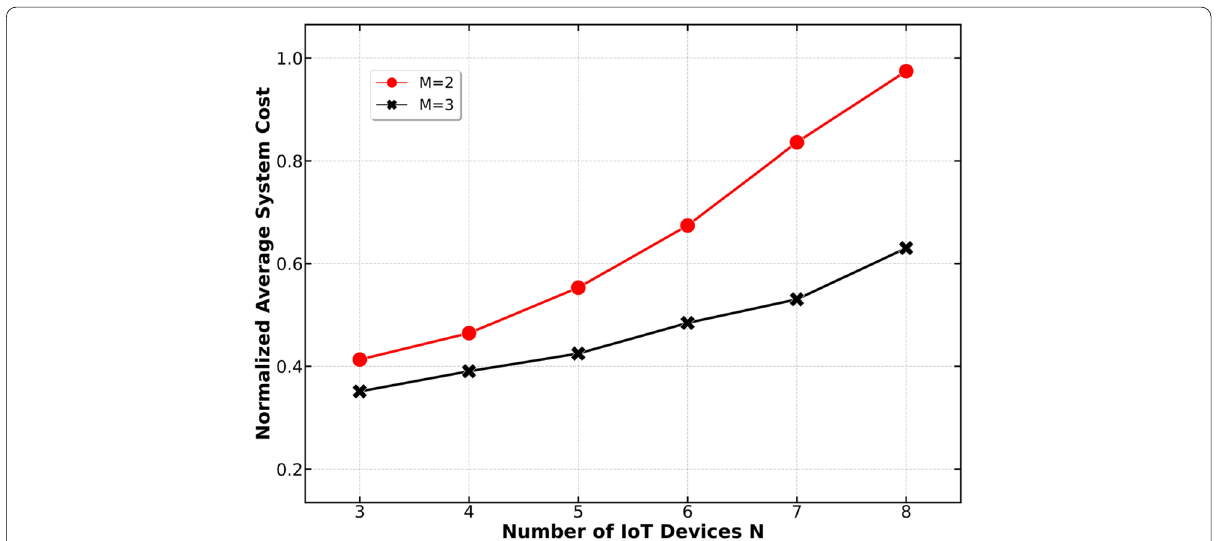
Fig. 4 Normalized average system costs with different number of IoT devices in the case of M = 2 and M = 3